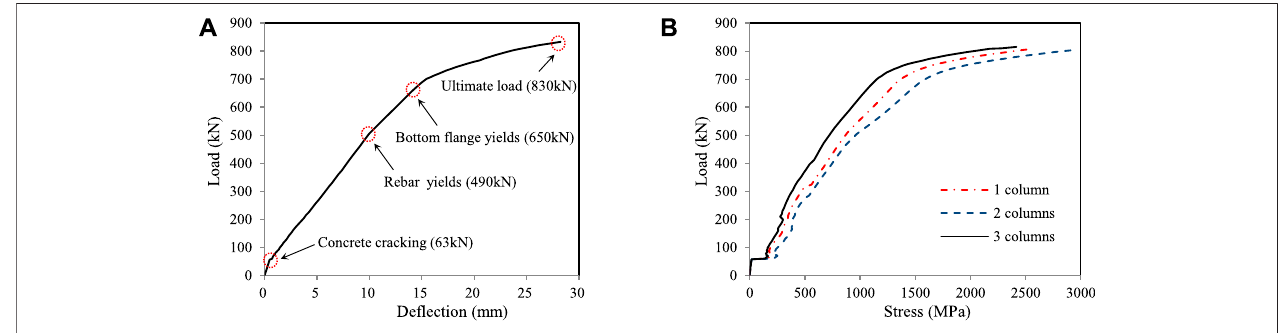
FIGURE 14 | Variation curves of de fl ection and CFRP stress: (A) load-de fl ection curve; (B) load-maximum tensile stress of the CFRP curve.